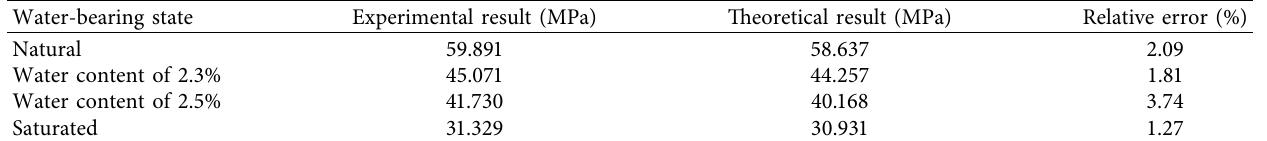
Table 1: Comparison of experimental and theoretical results of ultimate